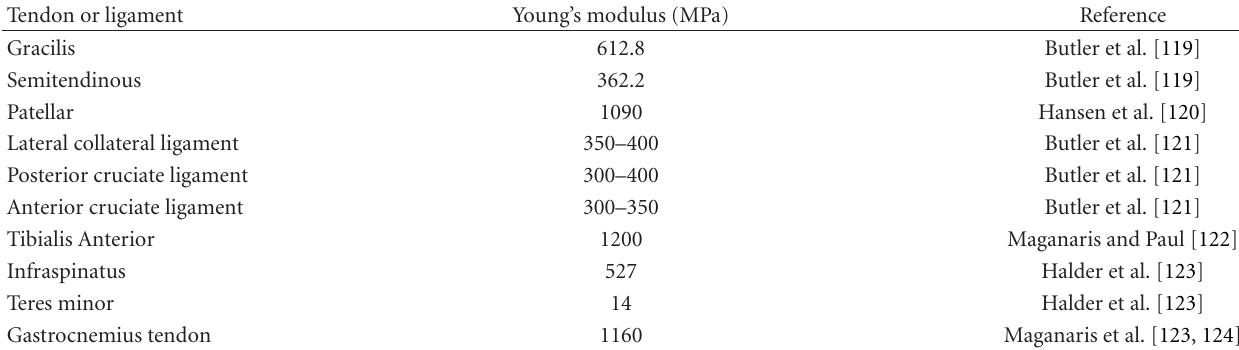
Table 3: Young’s Modulus of Human Tendons and Ligaments. Young’s Modulus = stress/strain = ( F/A ) / ( Δ L/L o ). Tendon or